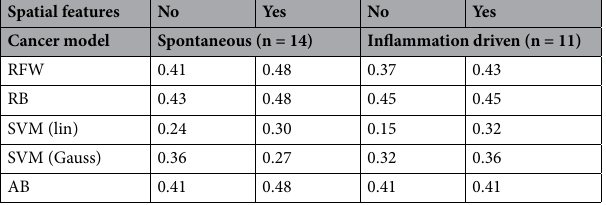
Table 5. Classification results of the MCC for all five classifiers as a function of spatial features and if inflammation driven tumour models are used or not.